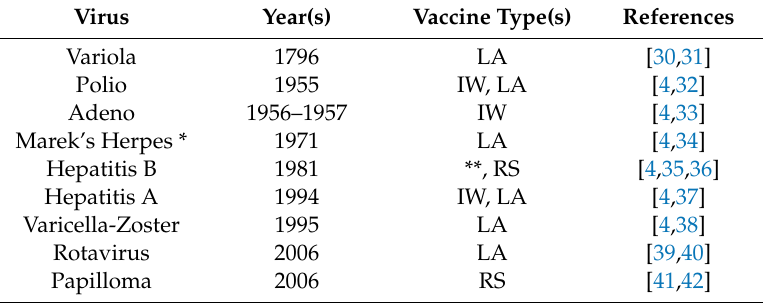
Table 2. Vaccines against other viruses. The single asterisk (*) refers to the only vaccine for animals. The double asterisk (**) refers to the unusual first vaccine for hepatitis